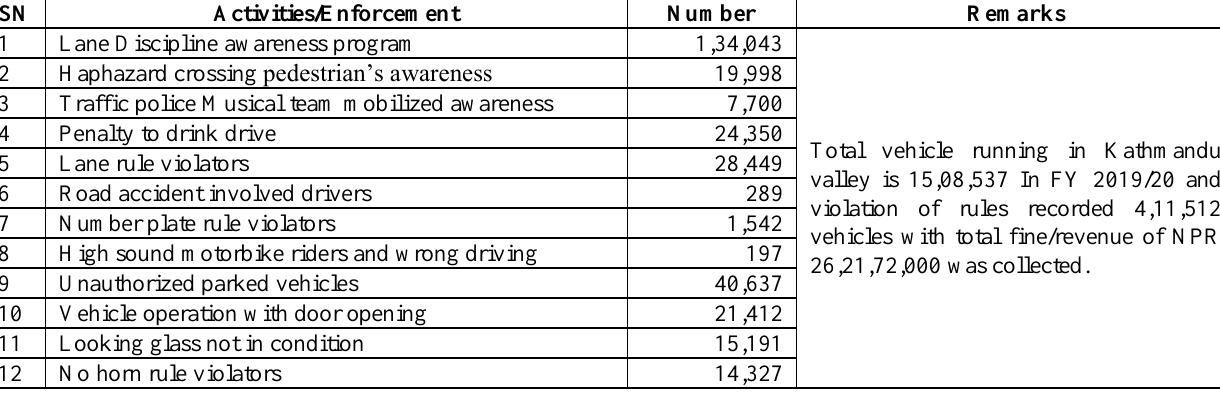
Table 30: Data of law enforcement by traffic police.